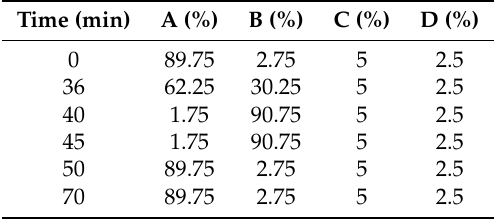
Table 2. Gradient timetable of the LC-QTOF method for monosaccharide analysis. Time